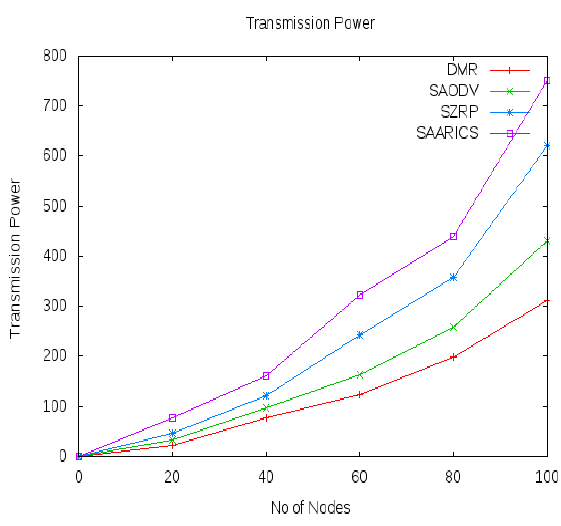
Figure 6. Transmission Power Range vs. Number of Nodes.